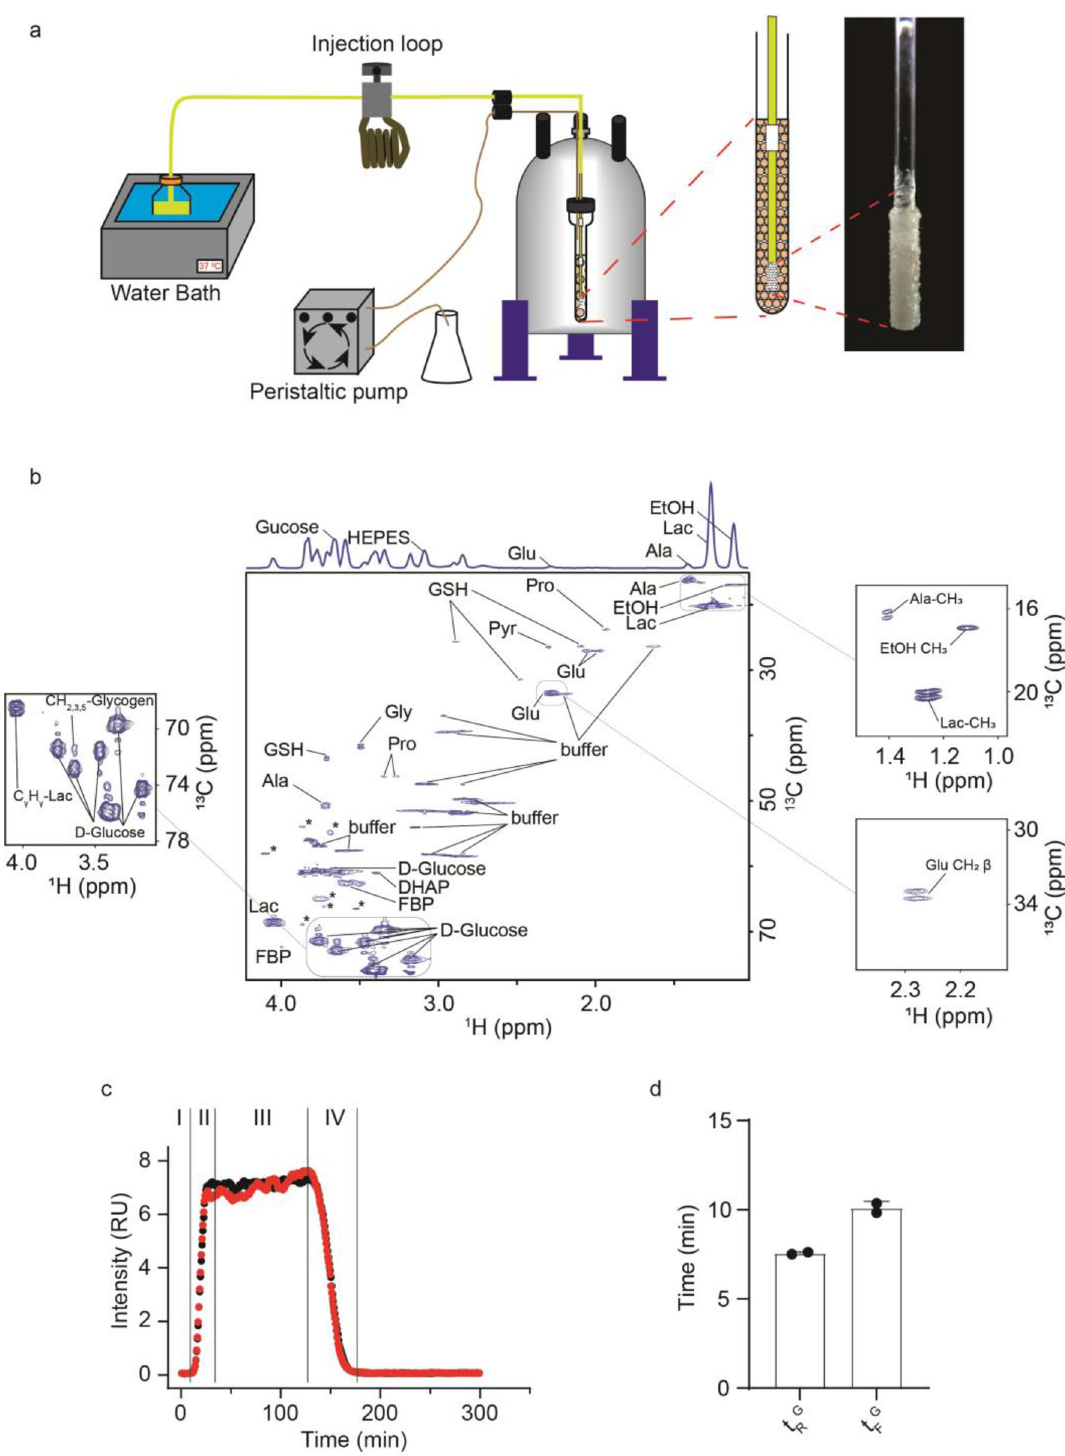
Figure 3. Real time pulse-chase NMR spectroscopy. ( a ) Bioreactor used for RT-PC NMR. The modified bioreactor includes an injectable loop for pulse-chase experiments or a valve for step-chase experiments. ( b ) 13 C edited heteronuclear single quantum coherence, 1 H- 13 C HSQC, NMR spectrum showing metabolites present in-cell. Insets show metabolite cross peak splitting and glycogen cross peaks. The projection of the 2D 1 H- 13 C HSQC into the proton dimension is on the top of the spectrum. The ethanol peak arises because ethanol was used to solubilize the palmitic acid supplement in the modified KH buffer. Unlabeled peaks from metabolites, which were not used for the analysis due to a low signal to noise ratio or overlap with buffer or glucose peaks after projection to the 1 H axis, are indicated with asterisk. ( c ) Normalized 13 C-glucose pulses chased with unlabeled glucose in non- transfected HEK 293T cells: (I) Prior to the pulse cells are fed unlabeled glucose in modified KH buffer; (II) During the incorporation stage a 15 mL pulse of 13 C-glucose is introduced through the injectable loop; (III) the 13 C-glucose reaches a plateau concentration; (IV) During the clearance stage the 13 C-glucose is eliminated from the system. During all the stages the individual metabolites are monitored as they progress through metabolic pathways. The red and black traces represent biological replicate samples. ( d ) Rise and fall times for the leading and trailing edges, t RG and t FG , of the pulses shown in panel